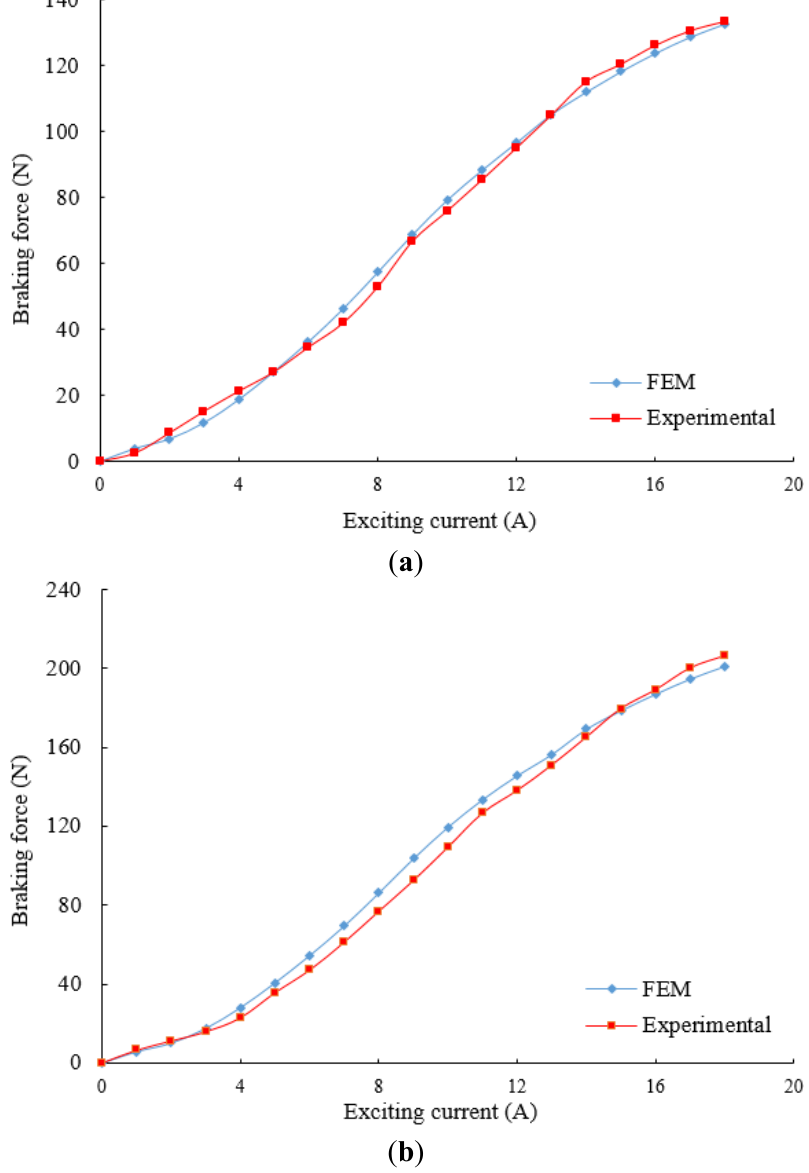
Figure 20. Comparison between the experimental measurements and calculated values via the finite element method: ( a ) v = 0.1 m/s and ( b ) v = 0.15 m/s. The output current of the full bridge power converter with the two-level PWM schemes